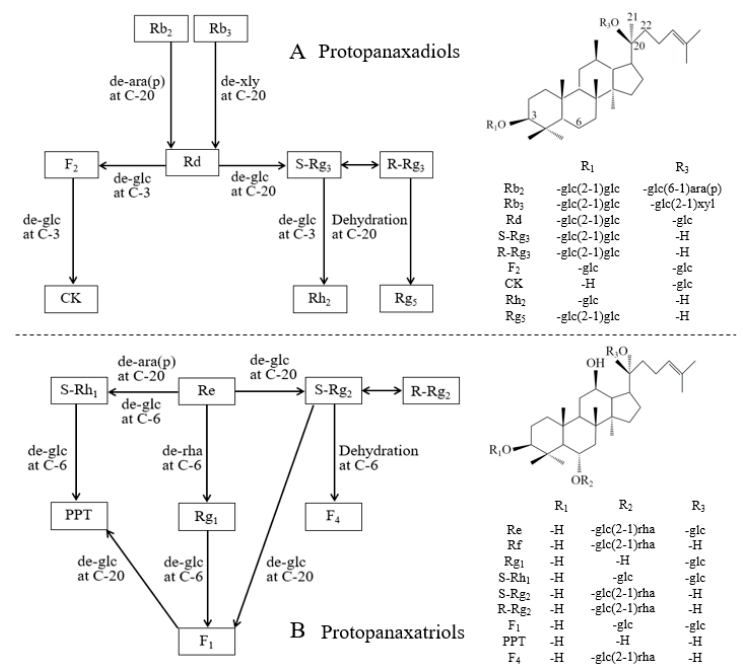
Figure 3. Chemical structures and possible transformation mechanisms of 18 representative ginsenosides in steamed GSEs. ( A ) Protopanaxadiols; and ( B ) protopanaxatriols. Glc, α -D-glucopyranosyl; Ara(f), α -L-arabinofuranosyl; Ara(p), α -L-arabinopyranosyl; Rha, α -L-rhamnopyranosyl; and Xyl, β -L-xylopyranosyl. Chemical links between C-20 and C-22 of F 4 and Rg 5 are double bonds.